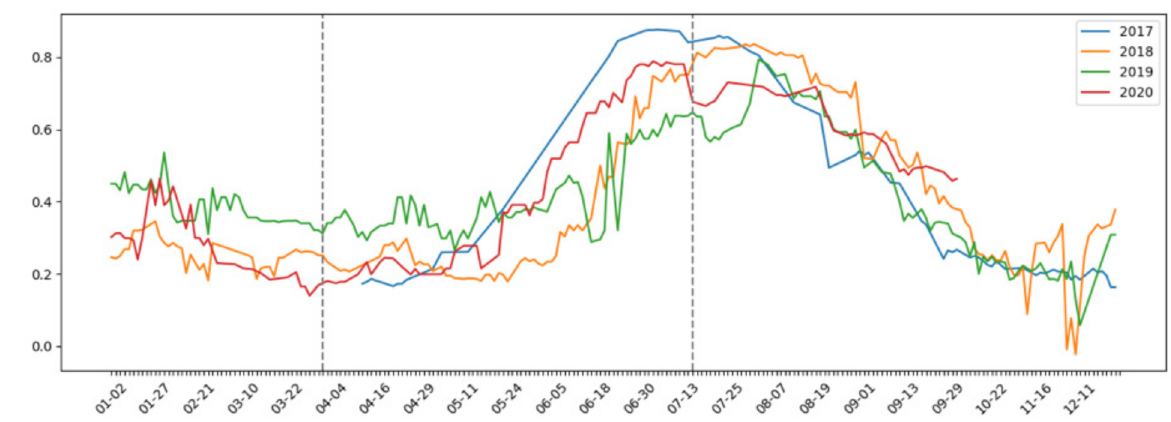
Figure 3. Representation of corn Normalised Difference Vegetation Index (NDVI) over 4 years. The two dashed lines represent the study period chosen to generate the network